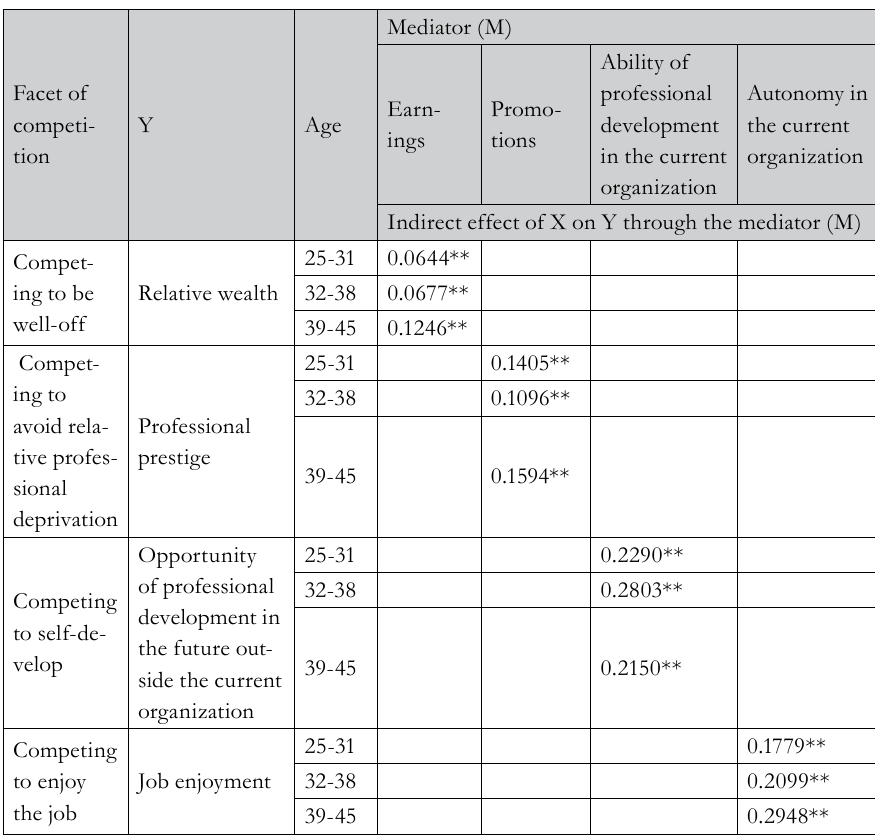
Tab. 1 – The indirect effects of improving the professional skills. Source: Own calculation on a base of the model 4 in the Process Hayes in